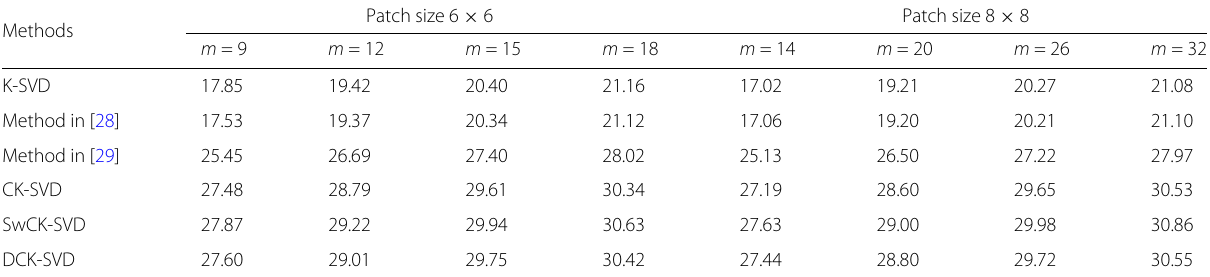
Table 4 Comparison of PSNR (dB) of reconstructed image “Penguin” with different number of measurements